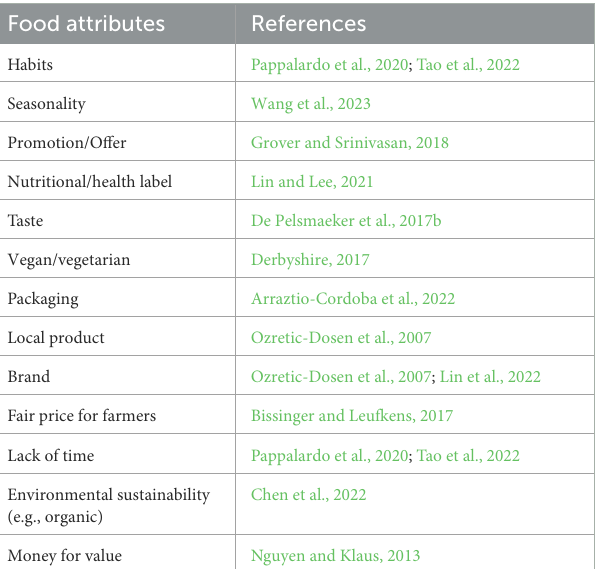
TABLE 3 Socio demographic characteristic of the sample.